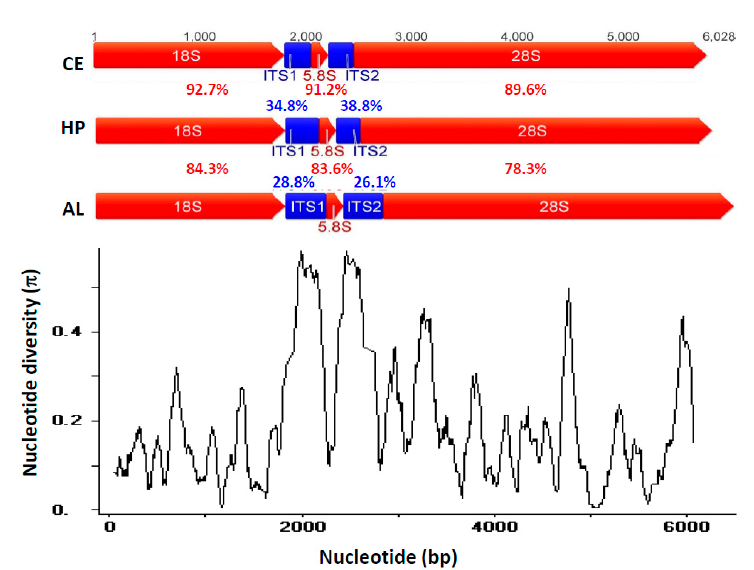
Figure 1. The complete 18-5.8-28S rRNA repeat unit of three green algae, Chlorella ellipsoidea , Haematococcus pluvialis and Aegagropila linnaei (Phylum Chlorophyta). The 18S, 5.8S and 28S rRNA genes are labeled in red, ITS1 and ITS2 sequences are labeled in blue. The nucleotide sequence identities are also highlighted for comparison. Lower panel shows the sliding window to compare the nucleotide diversity of 18-5.8-28S rDNA repeat unit assembly among three green algal species.